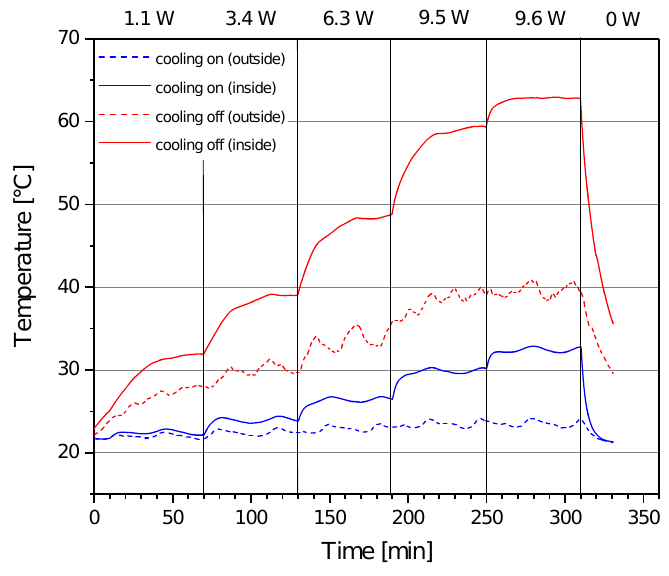
Figure 9. Effects on the temperatures inside and outside of the measurement chamber, with and without water cooling enabled, at different levels of